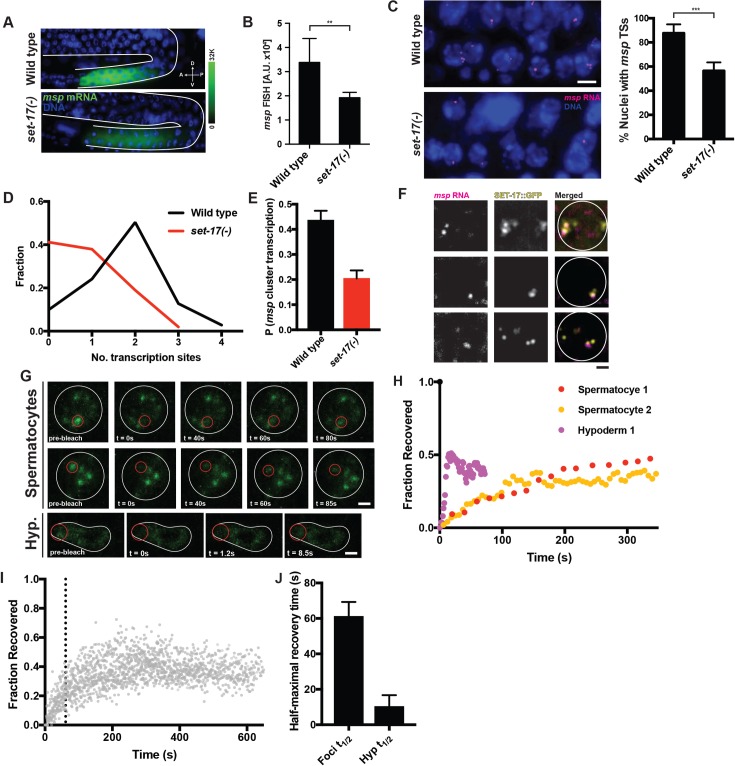
SET-17 promotes transcription at spermatogenic gene clusters.A) Endogenous msp mRNA expression determined by smFISH using a probe-set that recognizes transcripts from 28 msp genes in wild-type or set-17 sperm-producing germlines of L4 hermaphrodites. White lines delineate the gonad. Scale bar, 10 μm. B) Levels of endogenous msp mRNA as measured by smFISH in mature primary spermatocytes in wild-type and set-17 L4 hermaphrodites. n > 10, P < 0.001, t-test. C) Left, endogenous msp RNA transcription sites (TSs) in the nuclei of wild-type and set-17 primary spermatocytes in L4 hermaphrodites; scale bar, 5 μm. Right, percent of primary spermatocyte nuclei with at least one msp TS (positive). Wild type n = 177, set-17 n = 199. *** P < 0.0001, t-test. D) Frequency distribution of TSs in primary spermatocyte nuclei of wild-type or set-17(-) sperm-producing L4 hermaphrodites. Avg. TSs per nucleus: wild type, 1.75, n = 141; set-17, 0.82, n = 153; P < 0.0001, KS or MW test. E) Probability that a single msp cluster is transcribed in a wild-type or set-17 L4 hermaphrodite. Calculated from the TS distributions for wild-type and set-17 animals shown in (D). P < 0.0001, t-test. F) Co-localization of endogenous msp RNA TSs (as visualized by smFISH) and SET-17::GFP (as visualized by GFP protein fluorescence) in the nuclei of primary spermatocytes in the male germline. White circles, nuclear circumference; scale bar, 1 μm. G) Individual frames from an in vivo FRAP time series study of two primary spermatocytes and a hypodermal nucleus. White lines, nuclear circumference; scale bar, 1 μm; red circle, focal area of laser bleaching and region of measurement. H) Normalized fluorescence intensity measurement in the area of bleaching for the three experiments shown in (G). t = 0, pre-bleaching intensity. Recovery of SET-17::GFP is 10-fold slower in spermatocyte foci than in hypodermal nuclei. I) Normalized FRAP data for 16 experiments examining spermatocyte foci. Black dotted line indicates average half-maximal recovery time, 61 s, calculated from exponential fits for each experiment. J) Average half-maximal recovery times from FRAP studies of SET-17::GFP in spermatocyte foci (Foci t1/2) or hypodermal nuclei (Hyp t1/2). Error bars: SEM; P < 0.05, t-test.